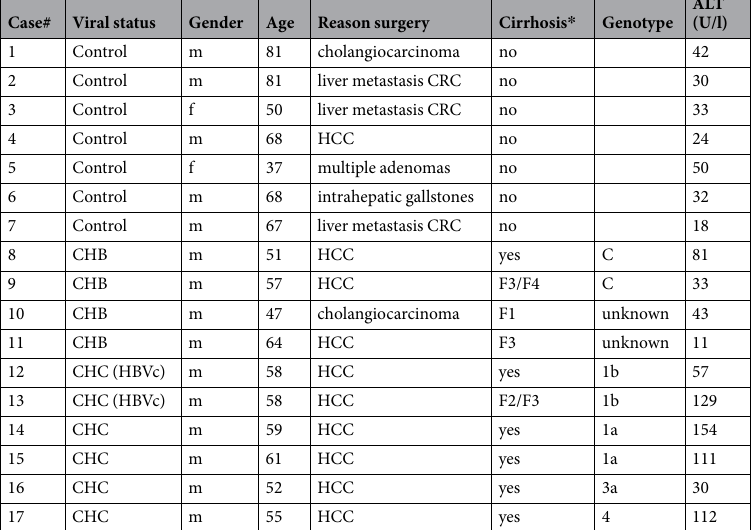
from control patients (n = 3) were stained using sequential immunohistochemistry 44 . Sections were deparaffin-